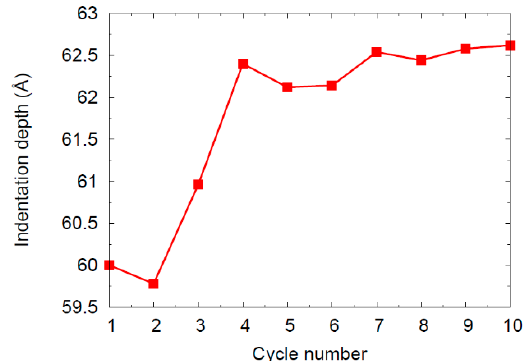
Figure 14. Dependence of the maximum indentation depth on cycle number.